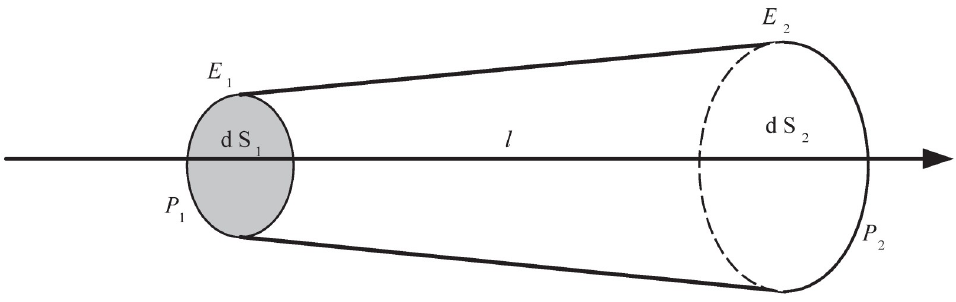
Fig 1. The propagation path of rays in a homogeneous